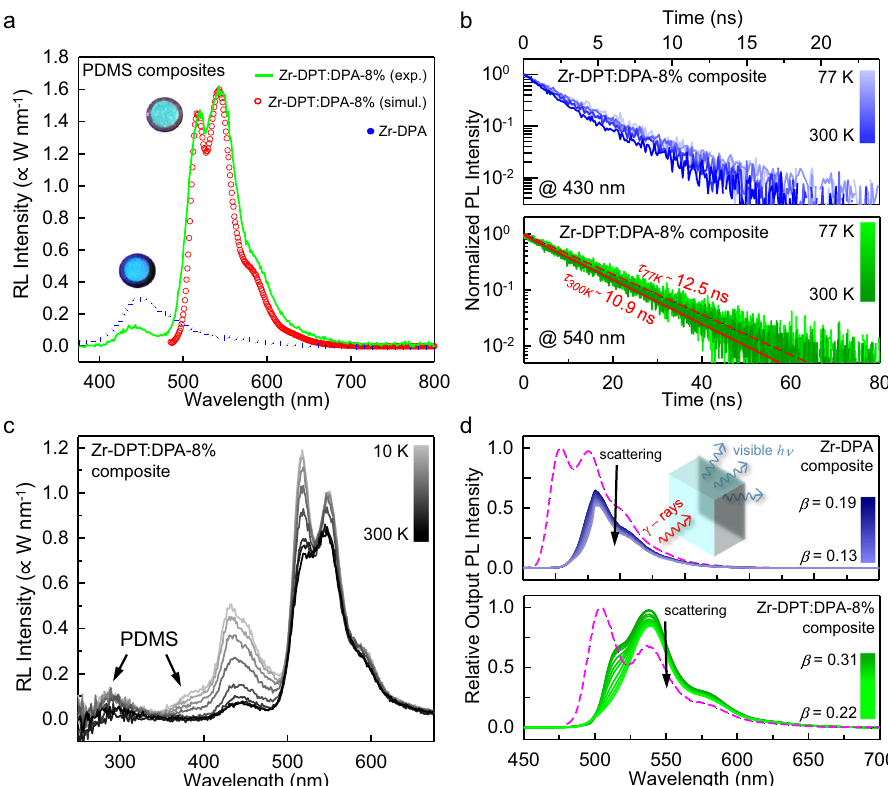
Fig. 4 Luminescence properties of large Stokes shift MOF-based nanocomposites under X-ray exposure. a Experimental and simulated radioluminescence (RL) spectrum of nanocomposites loaded with hetero -ligand Zr-DPT:DPA-8% and homo -ligand Zr-DPA nanocrystals fabricated by using polydimethylsiloxane (PDMS) as host polymer matrix (0.5% wt, 1 mm thickness) under X-ray exposure (digital pictures). b Zr-DPT:DPA-8% nanocomposite photoluminescence (PL) intensity decay recorded at 430 nm (top) and 540 nm (bottom) as function of the temperature under pulsed laser excitation at 405 nm. c RL spectrum of the Zr-DPT:DPA-8% nanocomposite as a function of the temperature. d Simulated output emission spectrum and ef fi ciency ( β ) as a function of the scattering level (from 0 cm − 1 to 20 cm − 1 ) in a 10 × 10 × 5 mm scintillator. Dashed lines depict the single molecule spectrum of the DPA (top) and DPT (bottom) chromophores for